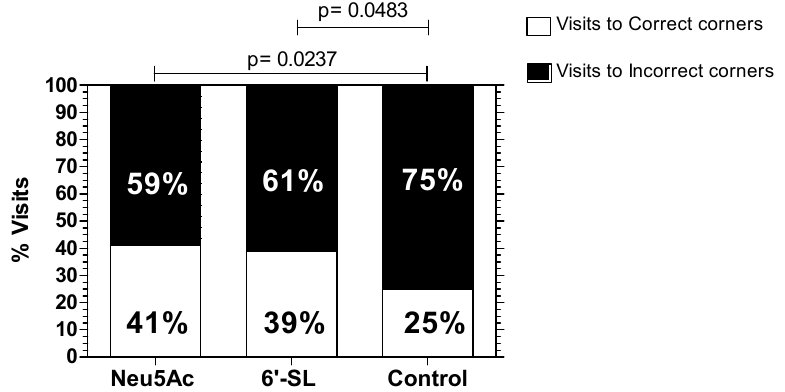
Figure 5. Percentage of total visits to the correct corner versus incorrect corner in the IntelliCage ® paradigm for each group of animals during the four drinking sessions of the two days of place learning. Fisher’s test was applied for statistical analysis; p < 0.05 denotes significant differences; n = 8 rats/group; one year of age. Neu5Ac, N-acetylneuraminic acid; 6 ′ -SL, 6 ′ -sialyllactose.